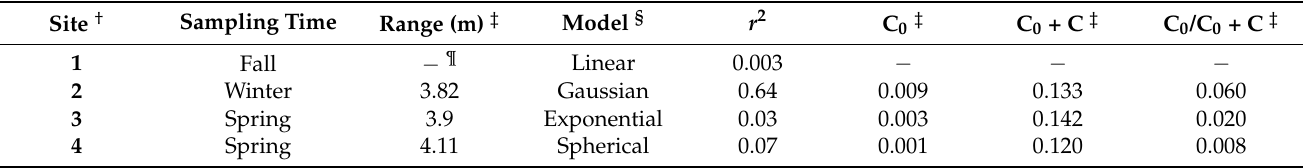
Table 1. Variogram models and parameters representing the spatial distribution patterns of Sphenophorus spp. larvae at four sites in Marshallville, Georgia (USA) in fall and winter 2019 and spring